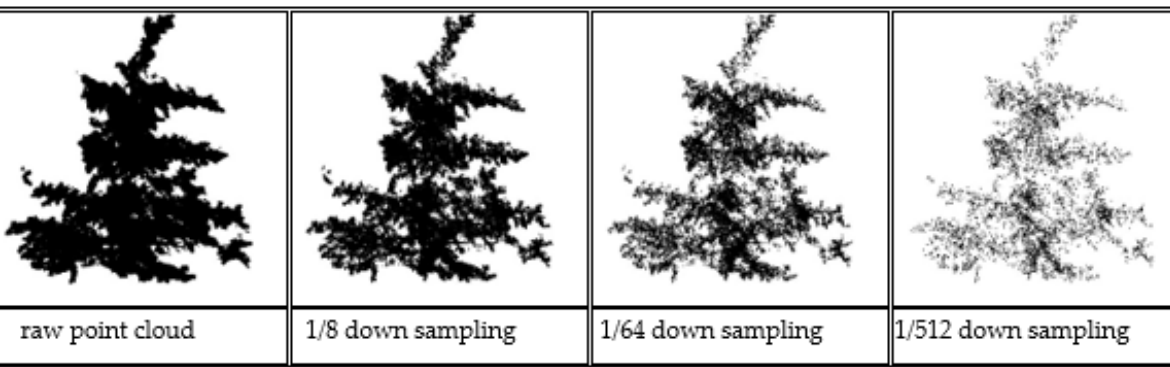
Figure 8. The ginkgo trees’ point cloud after last down sampling.